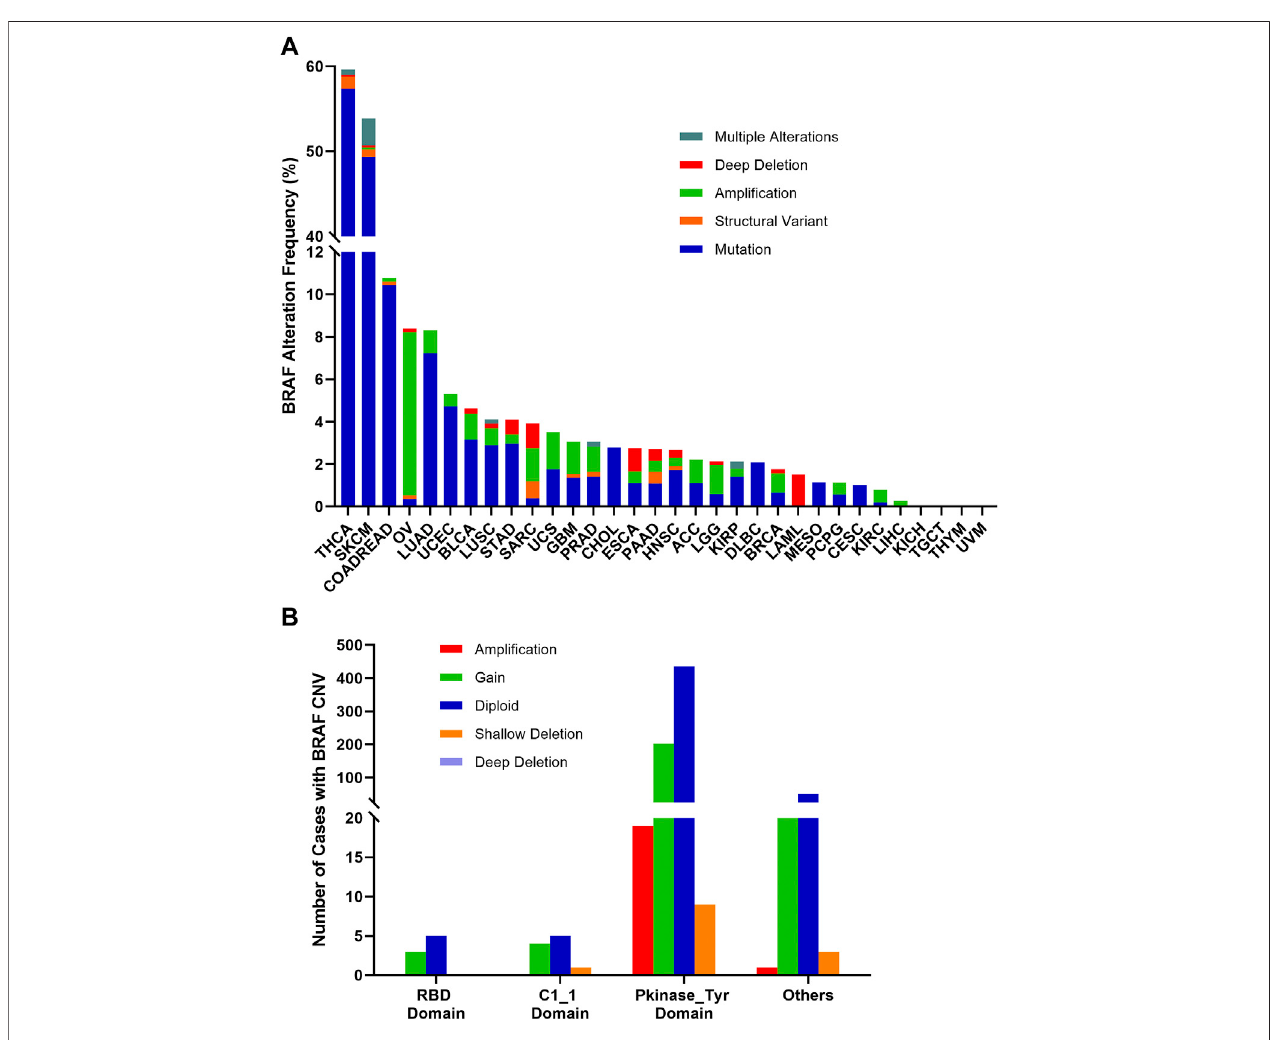
FIGURE 7 | BRAF alterations and distribution in pan-cancer. (A) BRAF alteration (mutations and CNVs) frequency across 32 TCGA tumor types. (B) BRAF CNVs distribution along with mutations located in different protein functional domains.